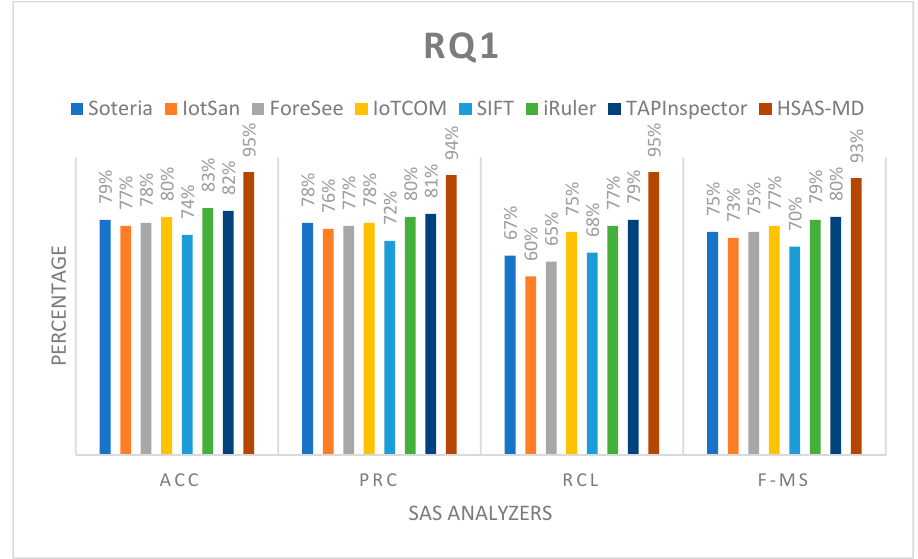
Figure 13. The comparison of the proposed HSAS-MD analyzer with other related analyzers based on ACC, PRC, RCL, and F-MS.